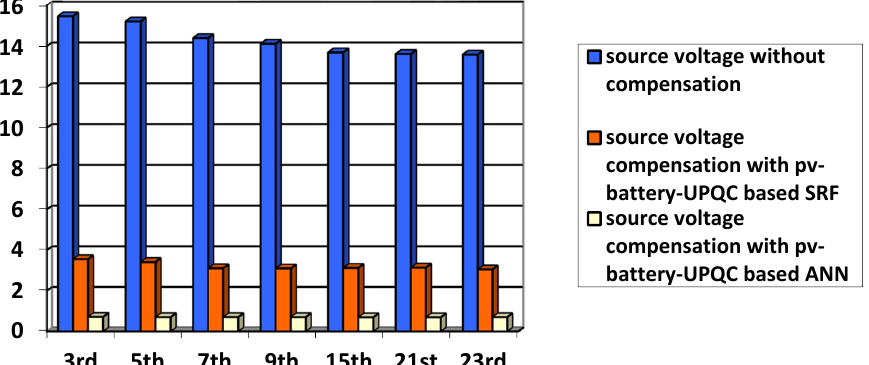
Figure 23. THD values of source and load voltage before and after compensation of PV-battery-UPQC based on SRF and ANN control techniques.